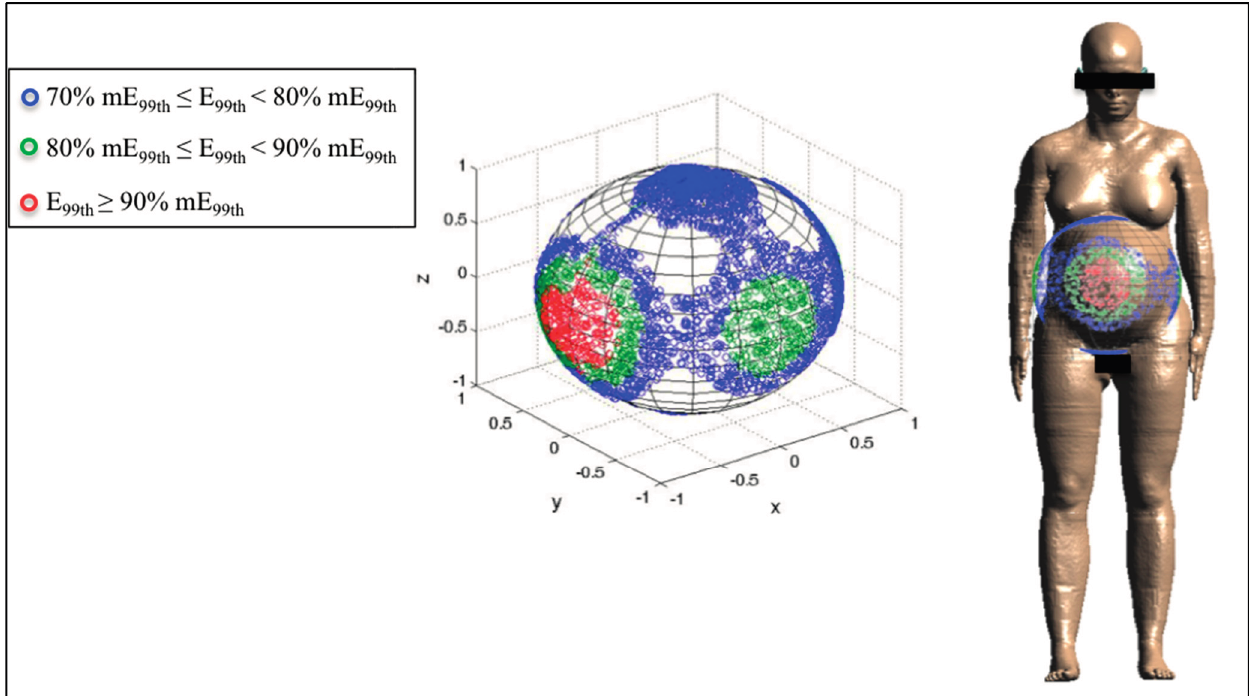
Figure 8. Distribution of B -field orientations on a unitary sphere represented in the pregnant woman’s reference system x,y,z (Figure 2), which determine, on the fetus whole-body at nine months GA, induced electric field E 99th in the ranges explained in Figure 6. The B orientations have been also indicated with respect to the reference system centered on the pregnant woman adopted in this